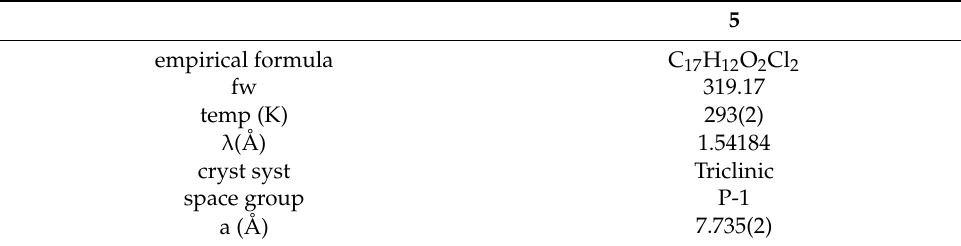
Table 1. Crystal data for